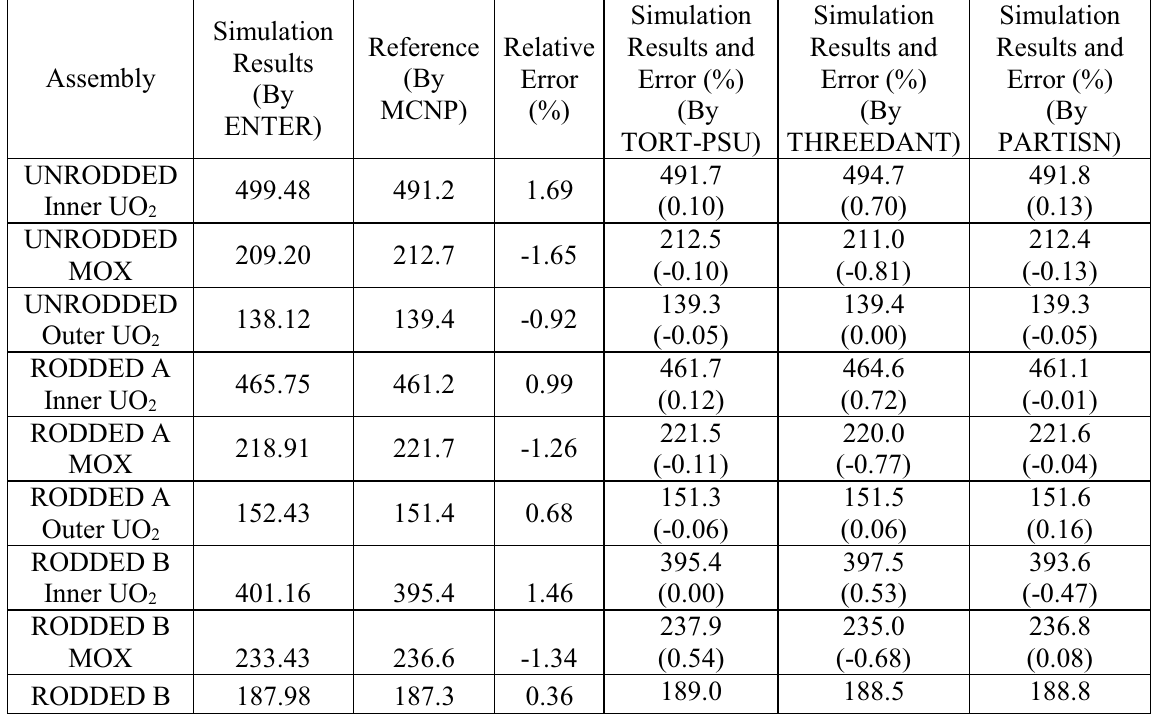
Table II: Results of Assembly